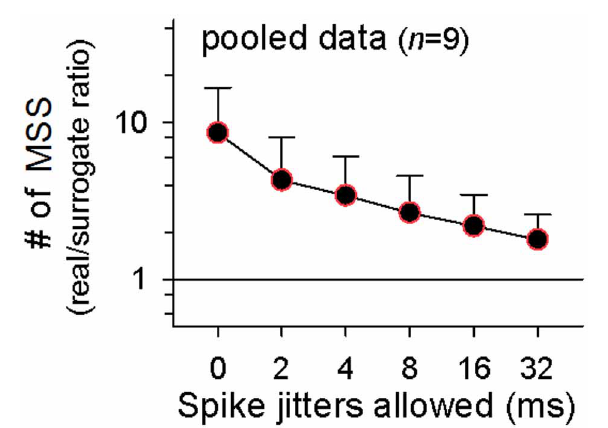
FIGURE 5 | Millisecond precision of MSSs. Summary of 9 videos. Color-edged circles are 5% significant data points between real datasets and surrogates (paired t -test). The data are the mean ± SDs.